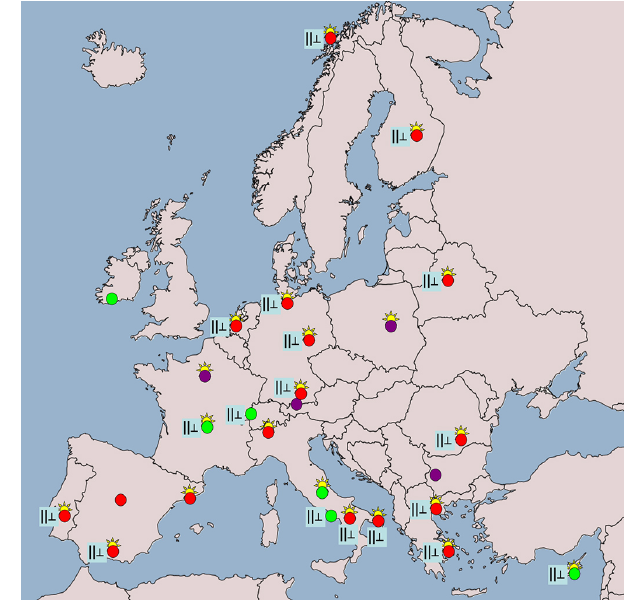
Figure 1. Map of the EARLINET stations currently active. Red dots indicate multiwavelength Raman lidar stations (EARLINET core stations). Green dots correspond to stations with at least one Raman channel. Violet dots denote lidars with only elastic backscatter channels. The ||⊥ symbol indicates that the station has depolarization-measurement capabilities. The “sun” symbol means collocation with an AERONET sun